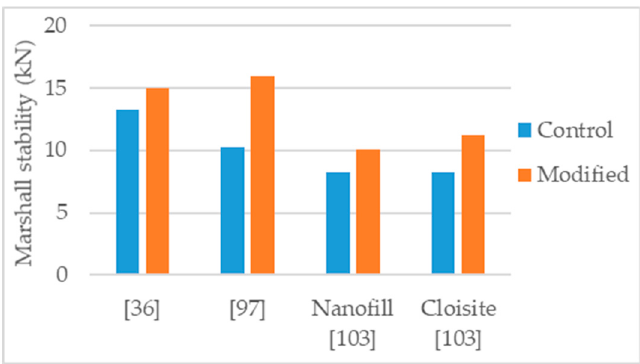
Figure 10. Marshall stability of control and nanoclay modified asphalt mixtures.